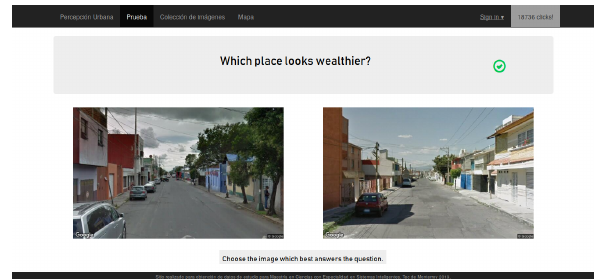
Figure 2. Perception Test Website.